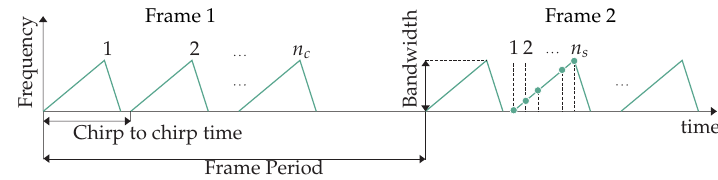
Figure 2. FMCW modulation and sampling